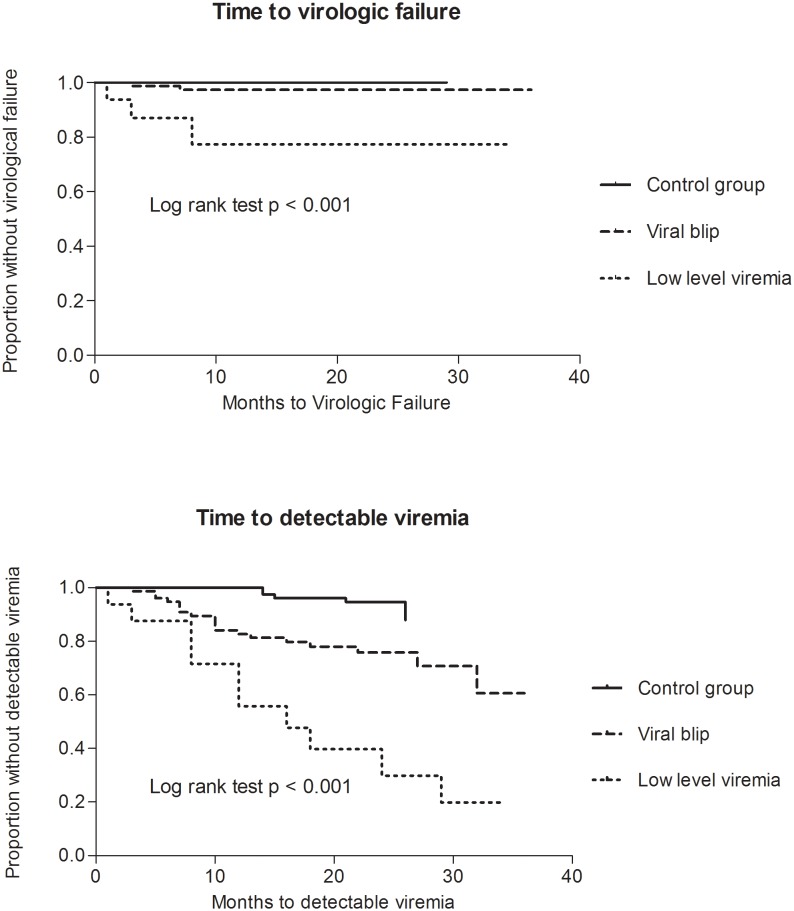
Kaplan-Meier plot of time to virologic failure (VL>1000 cp/mL) and of time to detectable viremia (≥50 cp/mL).